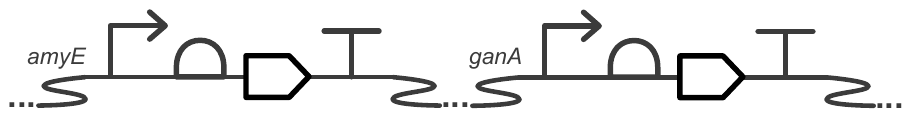
Figure 44: A functional unit consisting of promoter, ribosome entry site, CDS, and terminator, all integrated together into the chromosome.